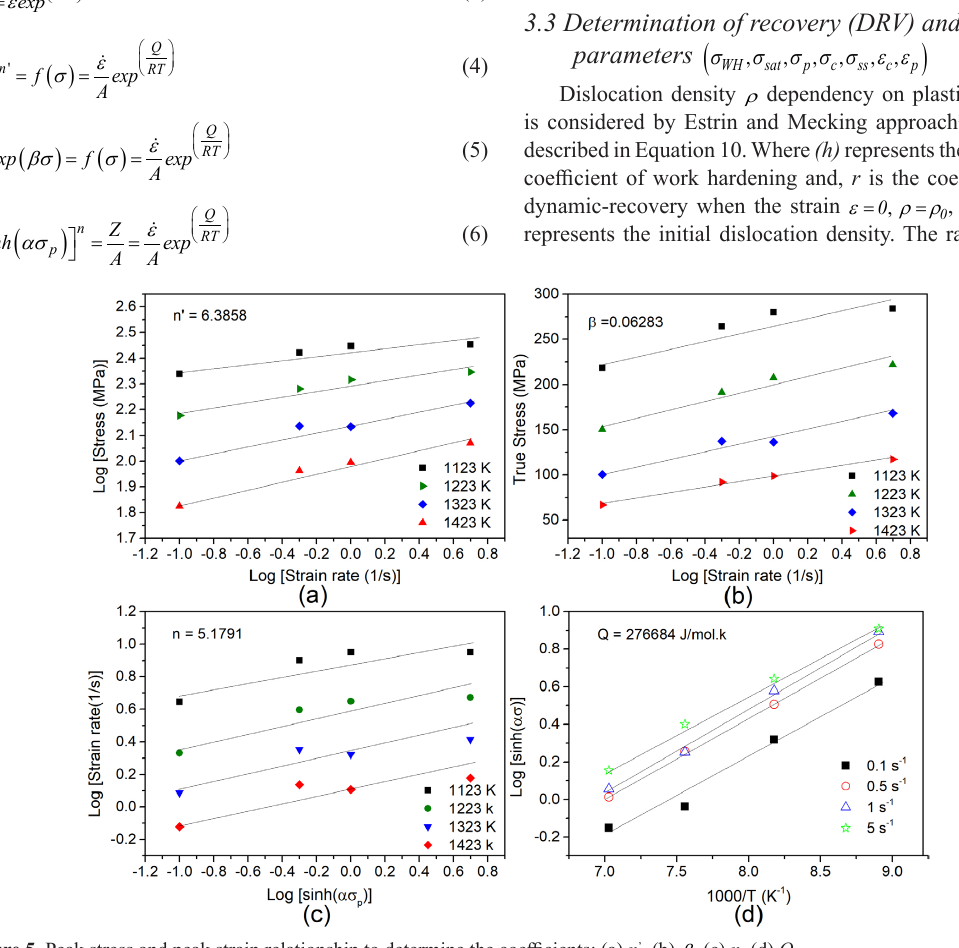
Figure 5. Peak stress and peak strain relationship to determine the coefficients: (a) n ’ , (b) β , (c) n , (d)